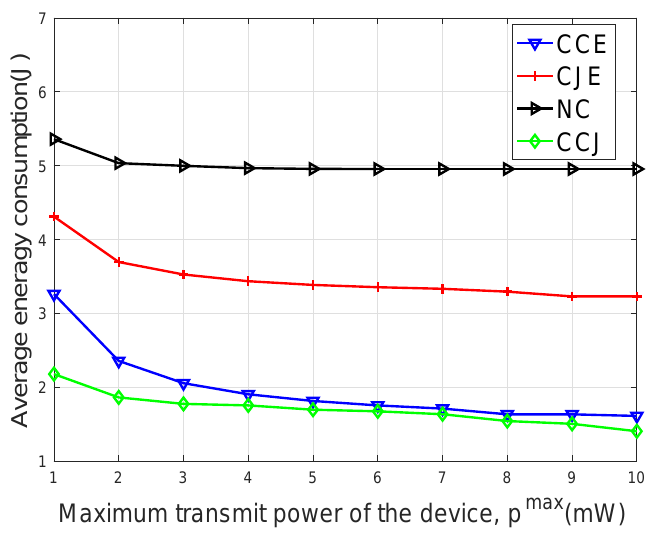
Figure 4. Average energy consumption of the four schemes versus the maximum achievable transmit power of device p max .